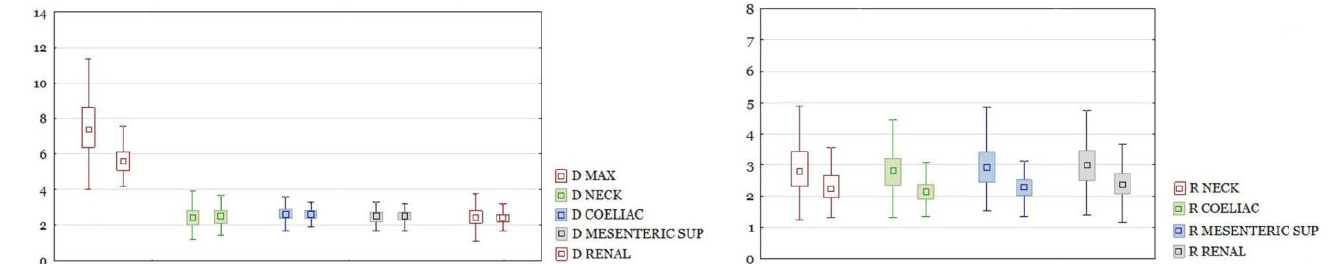
Figure 2. A comparison of aorta diameter (D RENAL) and renal ratio (R RENAL) between women (F) and men (M). D Renal for women from 1.4 to 3.5 cm with majority from 2.1 to 2.6 cm, D Renal for men from 1.1 to 4.7 cm with majority from 2.2 to 2.7 cm. R Renal for women from 0.2 to 0.6 with majority from 0.3 to 0.45, R renal for men from 0.14 to 0.88 with majority form 0.32 to 0.45. All differences insignificant p > 0.05.